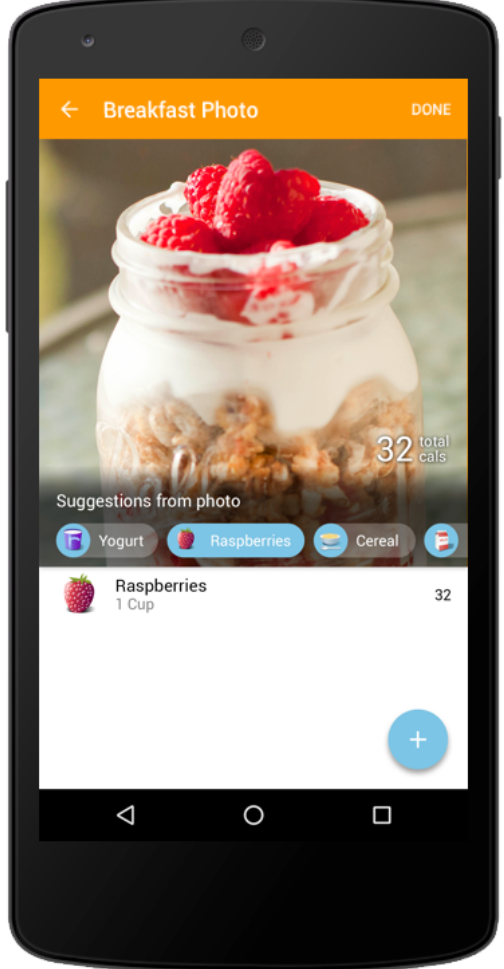
Figure 1. App photo feature. Users can take a snapshot of their food items before eating and select correct matches among a list of suggested items [33]. The calories and nutrients for the items are then